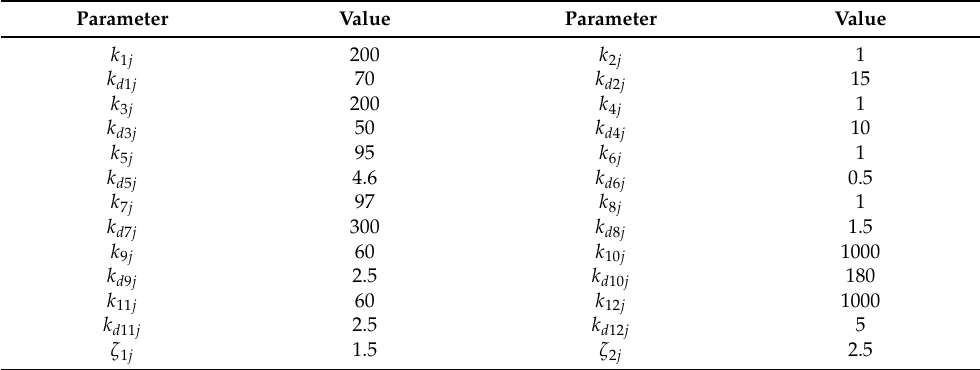
Table 3. Follower UAVs control parameters for attitude, altitude and position